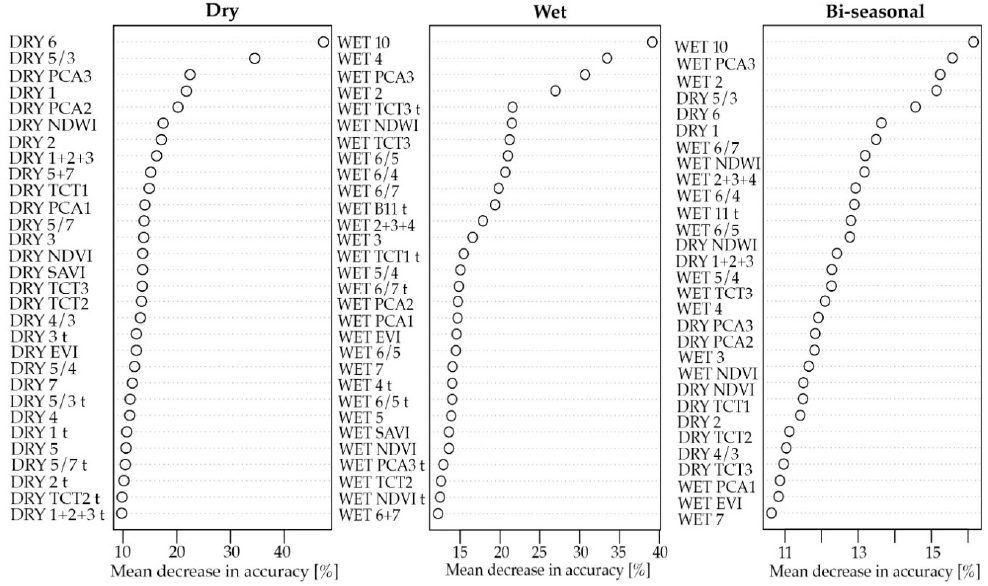
Figure 7. Variable importance measure for RF models with secondary forest data: ( a ) dry, ( b ) wet, and ( c ) bi-seasonal. Importance is estimated by mean decrease accuracy if a feature were left out in building a decision tree. For acronyms and formula details of predictor variables, see Table 1.